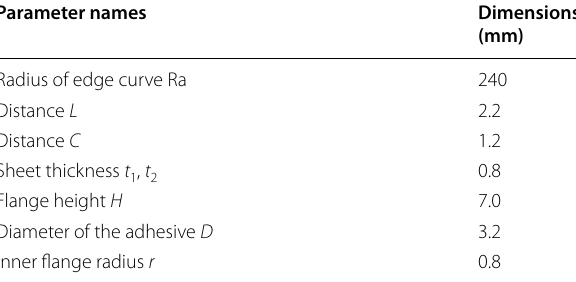
Table 3 Geometric parameters of